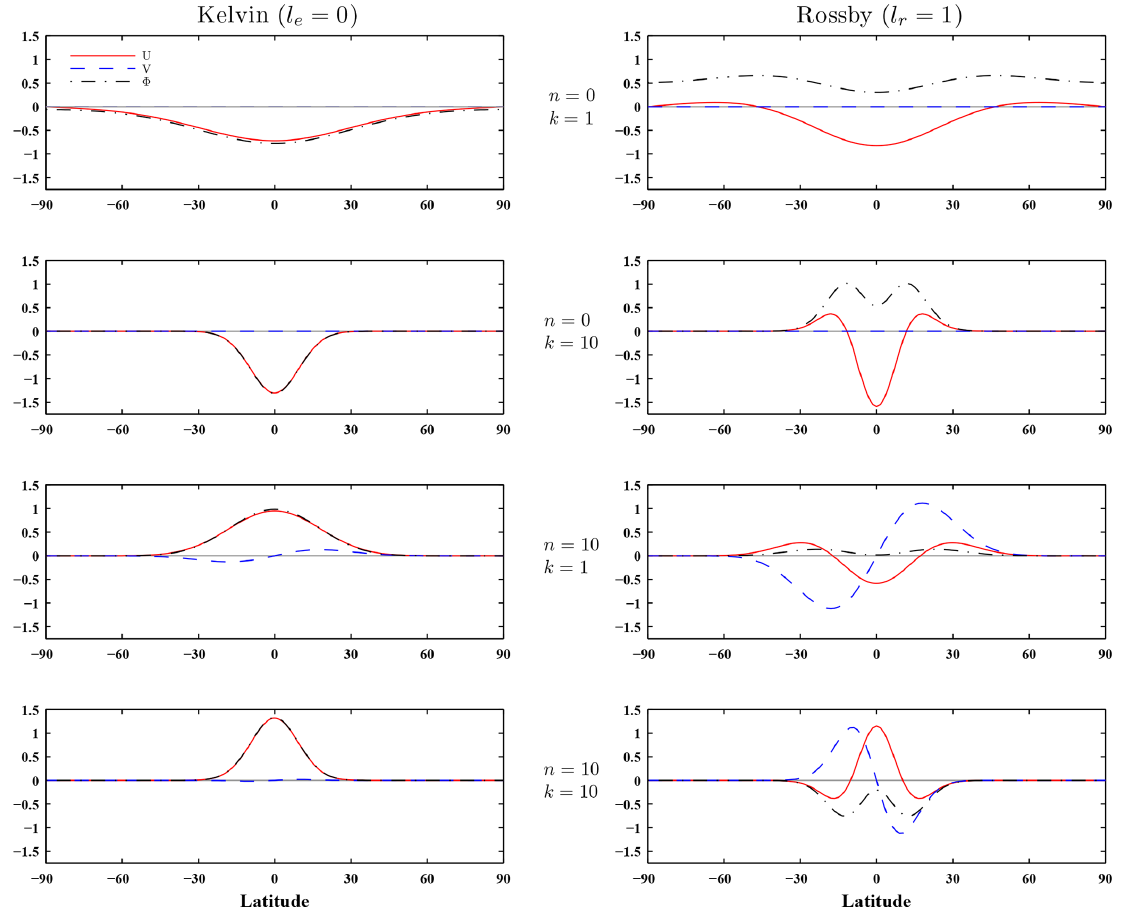
Figure 7. Meridional structures of two baroclinic Hough harmonics ( k = 1, h 1 (cid:39) 6 . 1km and k = 10, h 10 (cid:39) 65m) for the Kelvin mode l e = 0 (left column), the Rossby mode, l r = 1 (right column), and for two zonal wavenumbers, n = 0 and n = 10. The equivalent heights h k were obtained by solving the vertical structure equation with boundary conditions (14) and